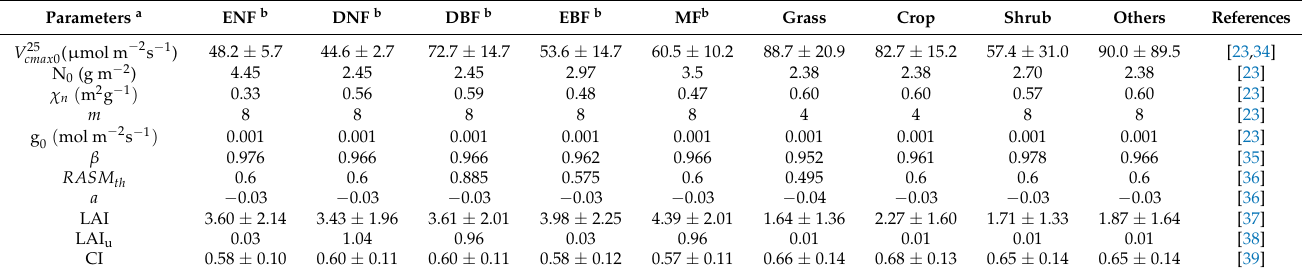
◦ C; N a V cmax0 is leaf maximum carboxylation rate at the top of the canopy at 25 0 is leaf nitrogen content at the top of canopy; χ n is the slope of V cmax variation with leaf nitrogen content; m and g 0 are the slope and intercept in the BWB equation. β is the simple numerical index of rooting distribution based on the asymptotic equation p ( z ) = 1 − β z , where p(z) is the proportion of roots from the surface to the depth (z). RASM th is the threshold of relatively available soil moisture. a is the fitted slope in the equation of accumulated soil water deficit (ASWD) adjusted V cmax ratio (Appendix A). The peak LAI during the growing season and the annual mean clumping index are given as the mean and standard deviation for each PFT. b ENF: evergreen needleleaf forests; DNF: deciduous needleleaf forests; DBF: deciduous broadleaf forests; EBF: evergreen broadleaf forests; MF: mixed